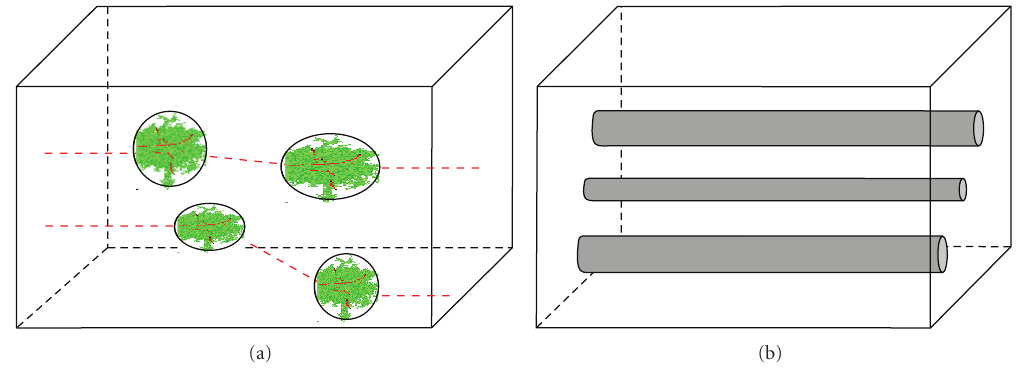
Figure 1: Schematic representation of the damage topology in crystals irradiated with slow (a) or swift (b)